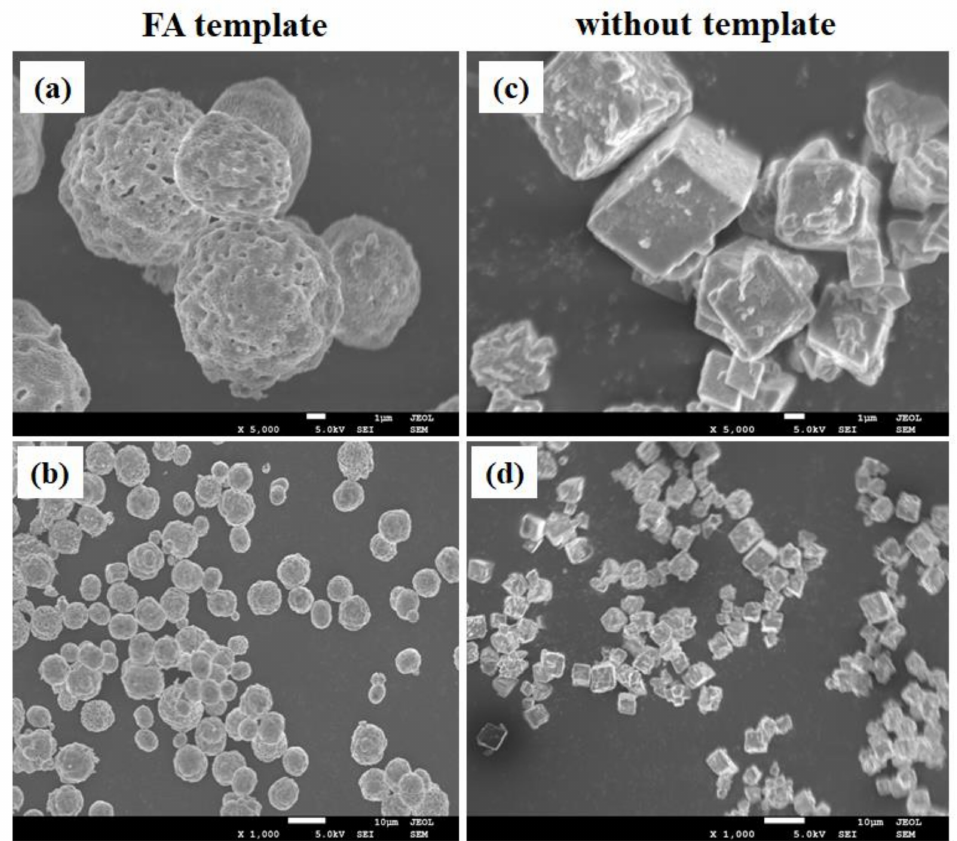
Figure 2. SEM images of ( a , b ) FA-CaCO 3 and ( c , d ) CaCO 3 prepared without a